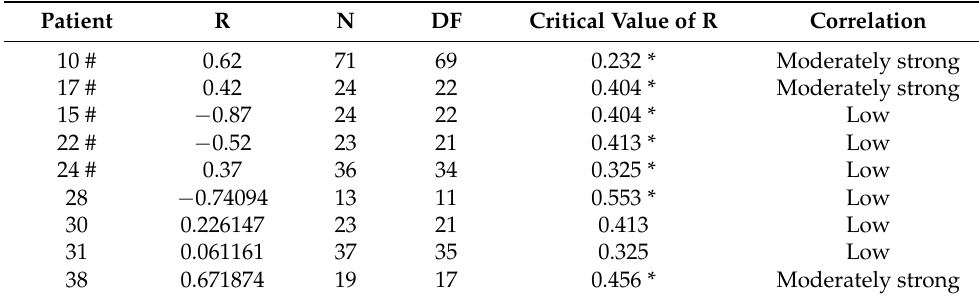
Table 2. Report of Pearson correlation values (R) for tumour core–peritumoural brain zone genomic profiles comparison. Patients’ pairs of biopsies were ranked into two groups: ones with a moderately strong correlation (0.40 ≤ R < 0.80); ones with a low correlation (R < 0.40). The statistical significance for each pair of correlations was calculated consulting the Table of Critical Values for Pearson’s R. N: total number of copy number alterations; DF: degree of freedom (N-2). Level of significance for a two-tailed test α = 0.05. * indicates statistically significant test. # shows data published in [11]. Patient R N DF Critical Value of R Correlation